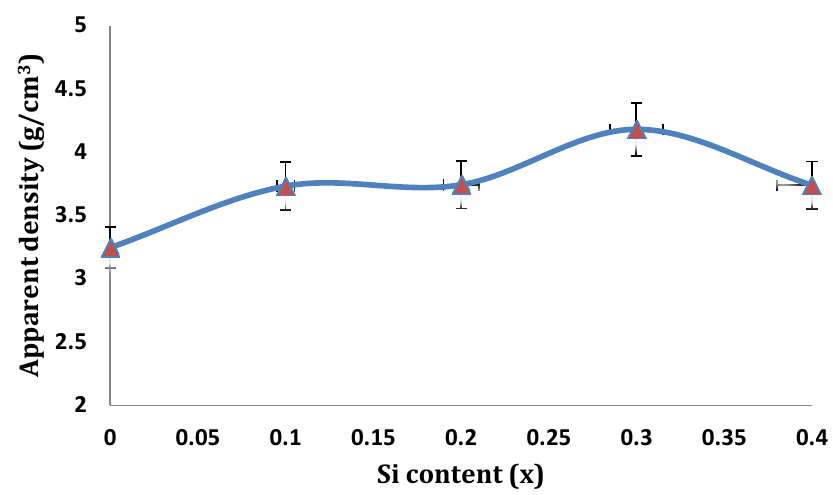
Fig. 3: The density of (Mg